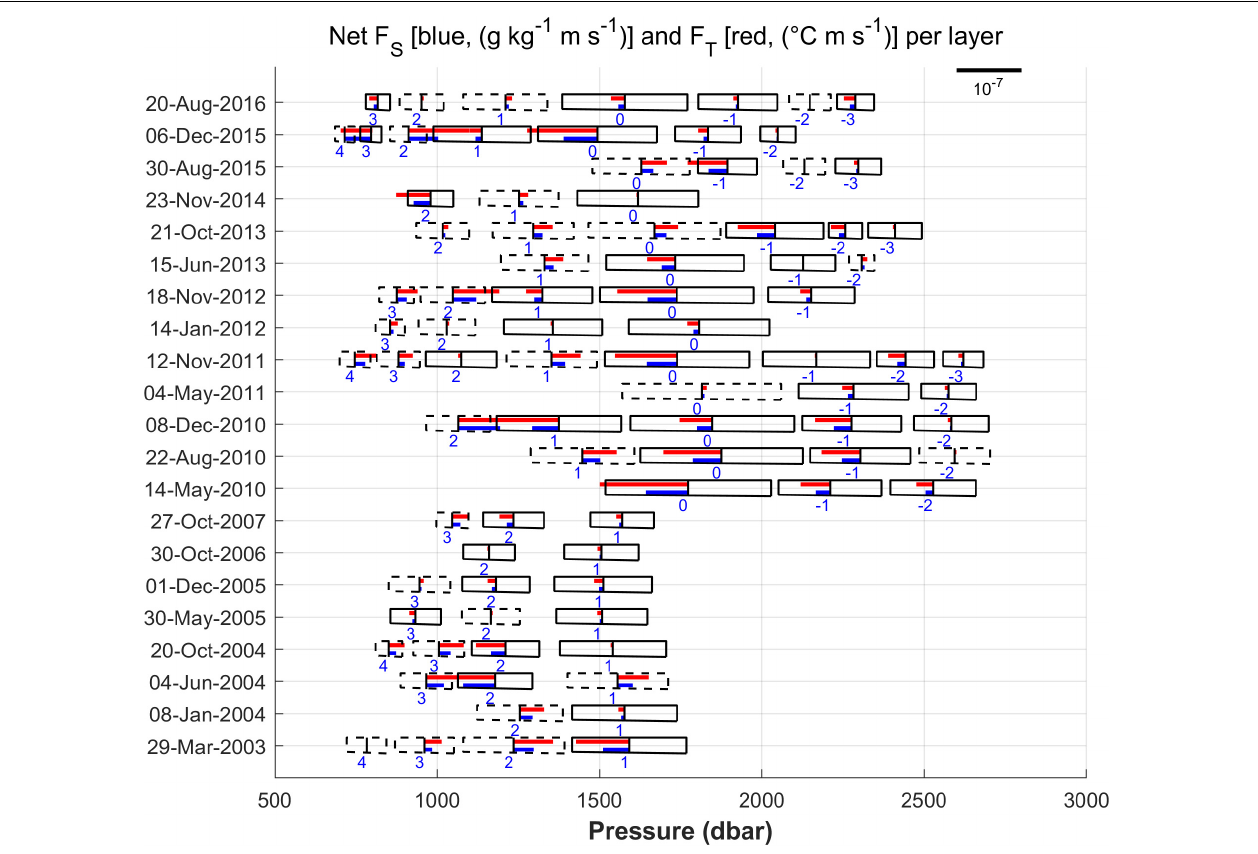
FIGURE 12 | The net fluxes of salinity and temperature (RS12) associated with the layers, i.e., the upper interface flux minus the lower interface flux for each layer. The rectangles represent the layers, numbered following the scheme laid down in Figure 3 . A dashed line delimiting a layer means that it exports more salinity/temperature than it receives, and a similar solid line means exactly the opposite. The orientation of a flux bar to the left or to the right indicates a net flux into or out of a layer,